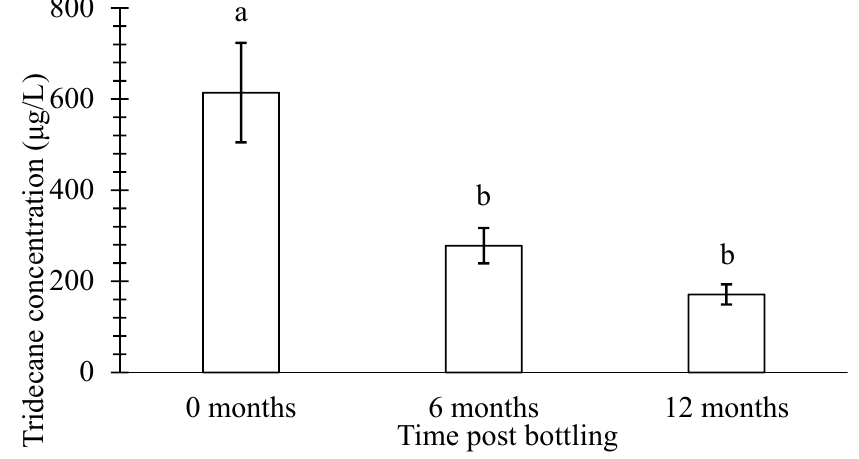
Figure 1. Tridecane concentration in Pinot noir made from BMSB containing grapes, PN2 at 0, 6 and 12 months of bottle aging ( n = 3). Means with the same letter are not significantly different from each other (Tukey’s HSD, α : 0.05).